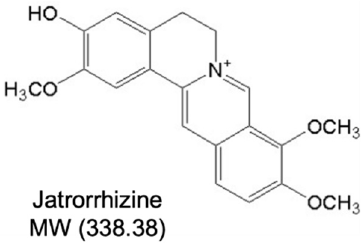
Figure 1. Structure of jatrorrhizine.